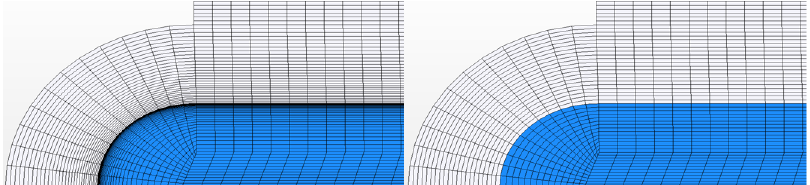
Figure 3: Details of the mesh in the cross section of the STAR-CCM+ models (left) with y+ < 5, (right) with y+ >